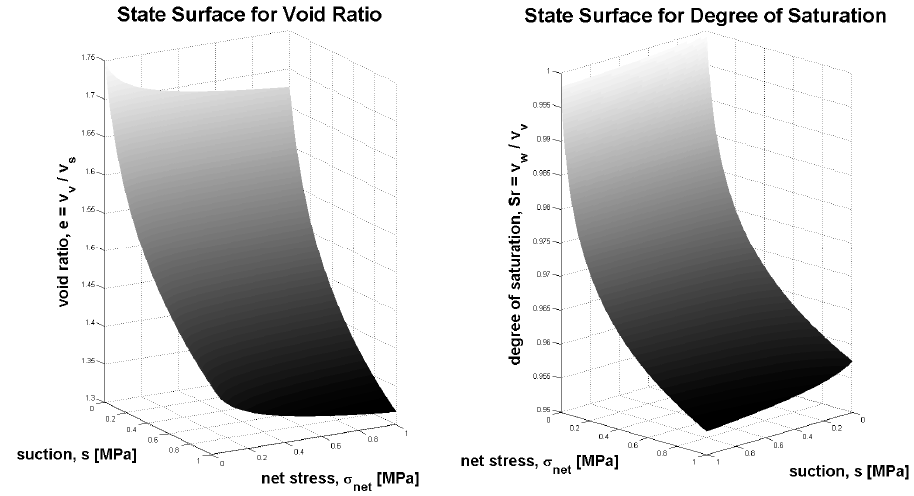
Figure 2. State Figure 2. State surfaces.